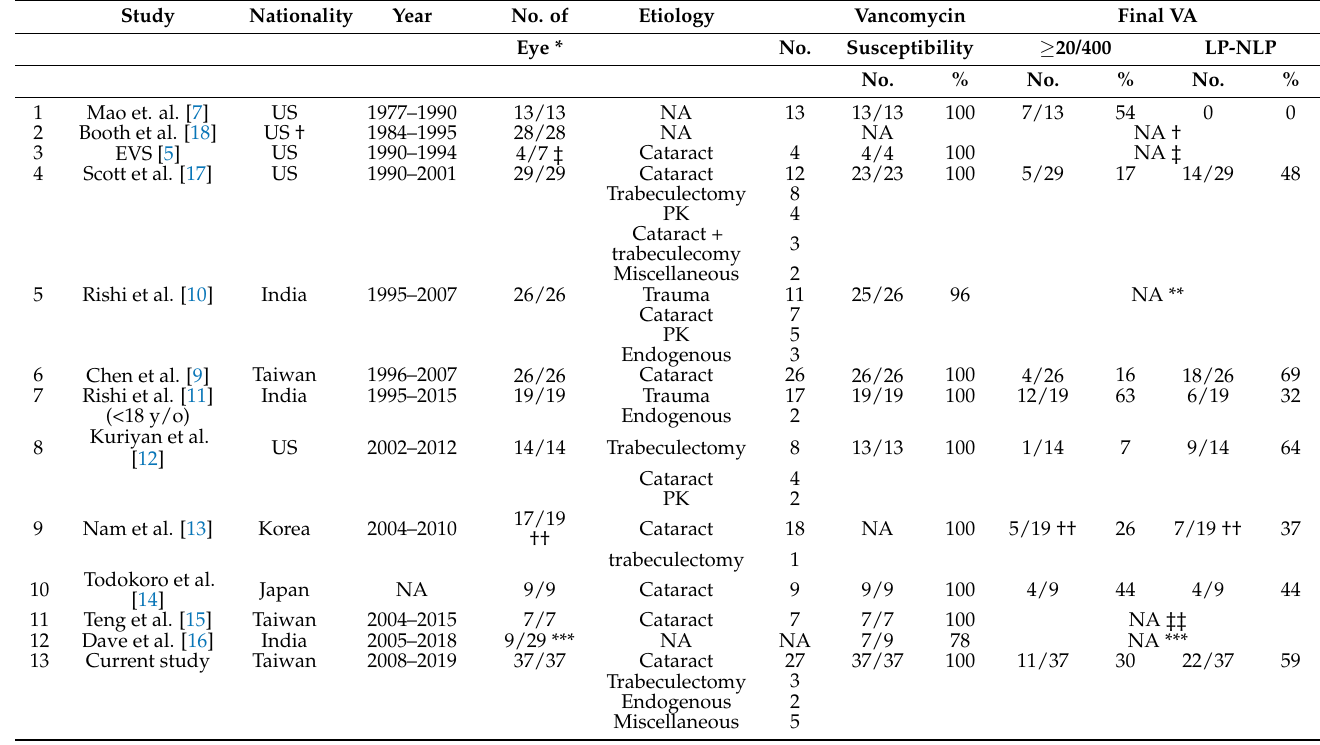
Table 2. Comparison of studies of endophthalmitis caused by Enterococcus